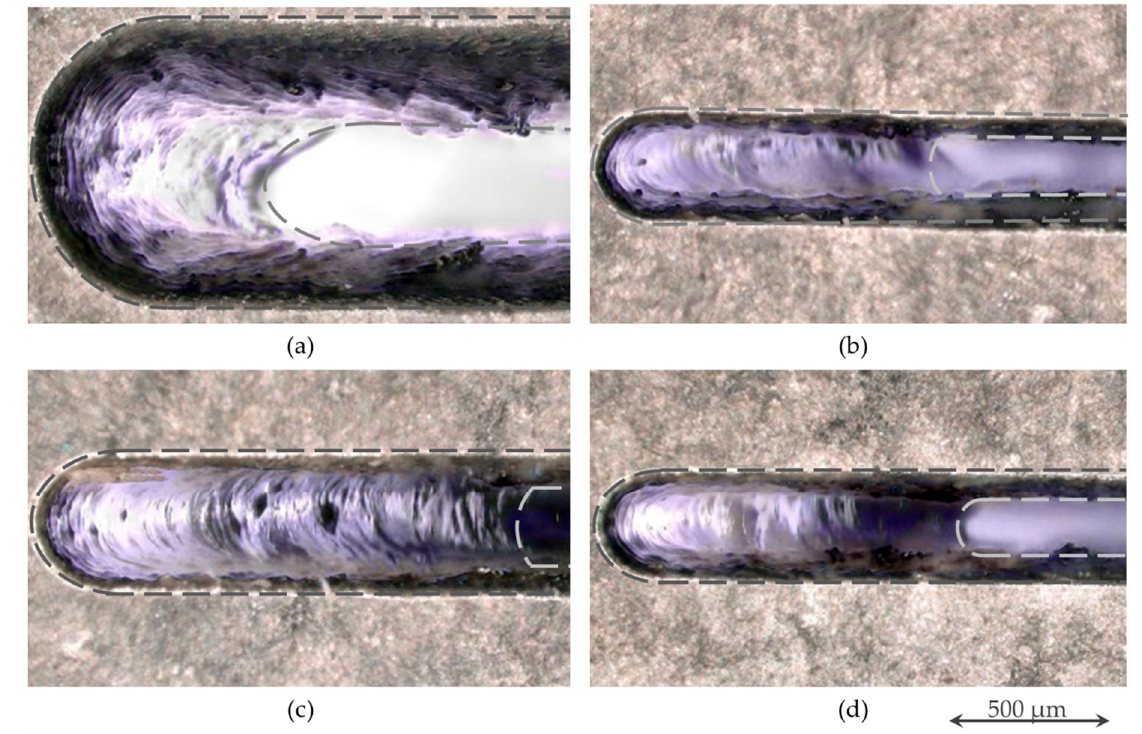
Figure 10. Position of the cut front und cut kerf regarding the camera image of 12 mm stainless steel cut with the following parameters: ( a ) Set #1: Static beam shaping and different values of the longitudinal, linear beam oscillation parameters: ( b ) Set #2: 300 µm amplitude and 500 Hz frequency; ( c ) Set #3: 550 µm amplitude and 500 Hz frequency; ( d ) Set #4: 300 µm amplitude and 2000 Hz frequency.